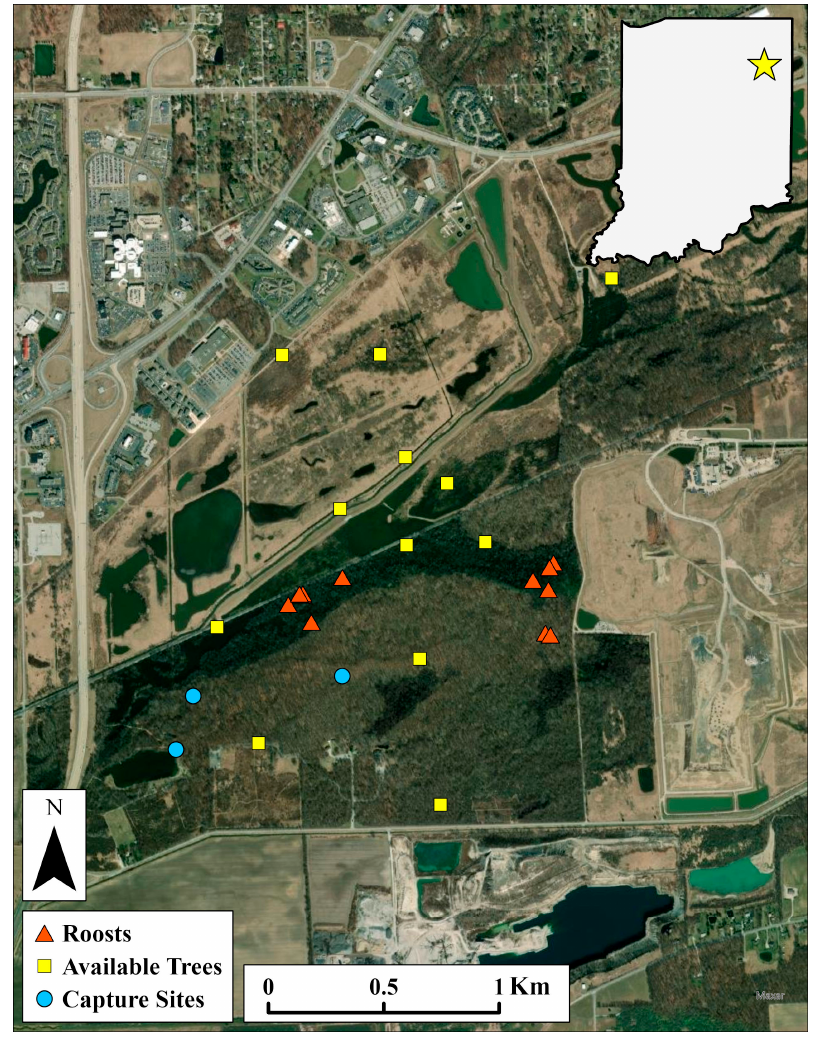
Figure 1. Map of Fox Island County Park and Eagle Marsh Nature Preserve in Fort Wayne, Indiana, USA (star). Adult female and juvenile northern long-eared bats ( Myotis septentrionalis ) were captured at three out of eight total net sites and tracked back to their day roosts between May and August 2019–2021. To study roost selection in this colony, characteristics of roosts were compared to characteristics of available trees, located randomly within 0.9 ± 0.4 km buffers (average distance between roosts and capture sites) around each roost.